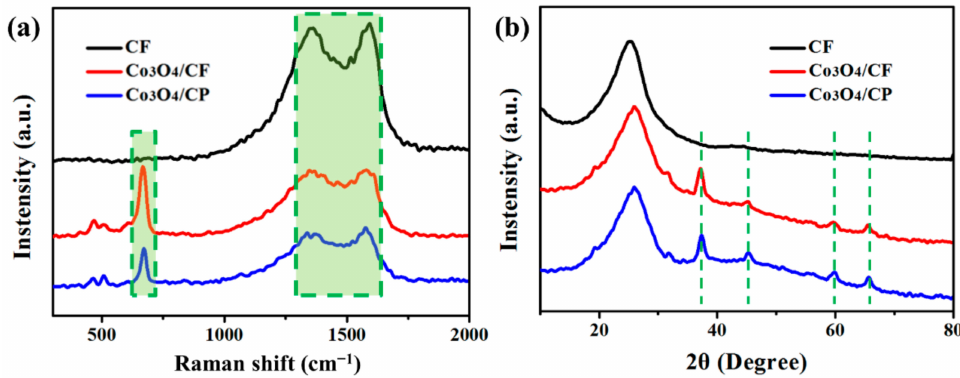
Figure 4. ( a ) Raman spectra of CF, Co 3 O 4 /CF, Co 3 O 4 /CP; ( b ) XRD spectra of CF, Co 3 O 4 /CF, Co 3 O 4